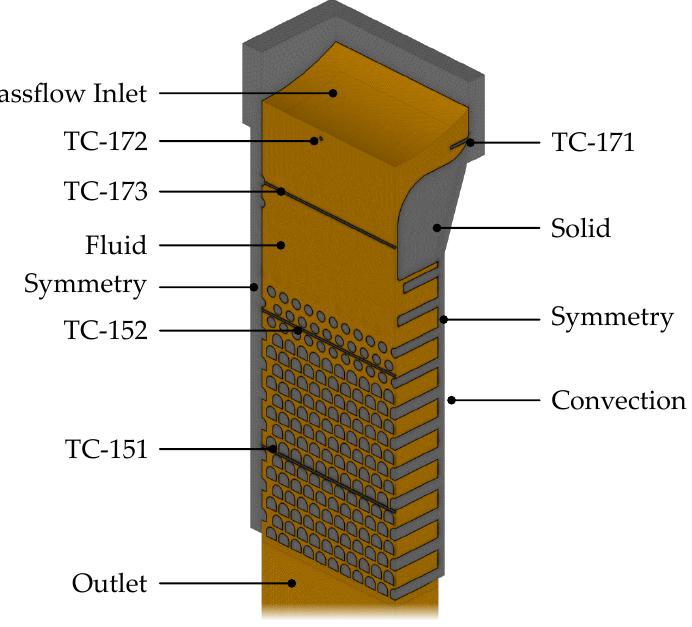
Figure 3. Three-dimensional numerical model of the heat exchanger. It is reduced to a quarter of the actual geometry using symmetry planes. Solid parts are shown in gray, the hot gas flowing from the top to the bottom is shown in orange. The coolant liquid is modelled as a convective heat transfer boundary